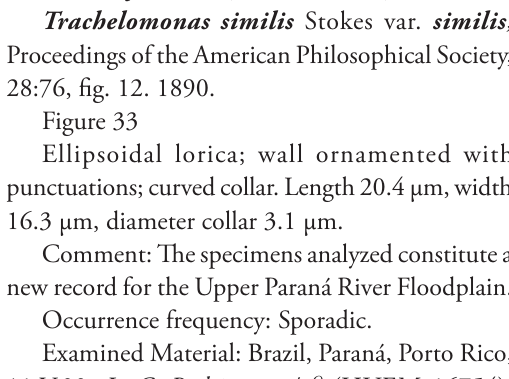
Spherical lorica; smooth wall; short collar; numerous discoid chloroplasts distributed all over